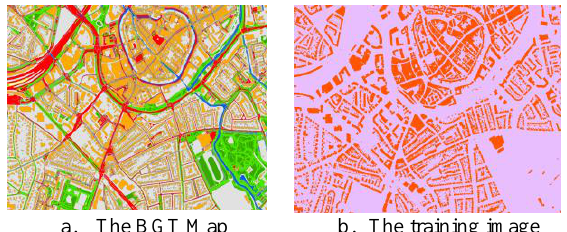
Figure 7. The BGT map is aggregated into labelled image